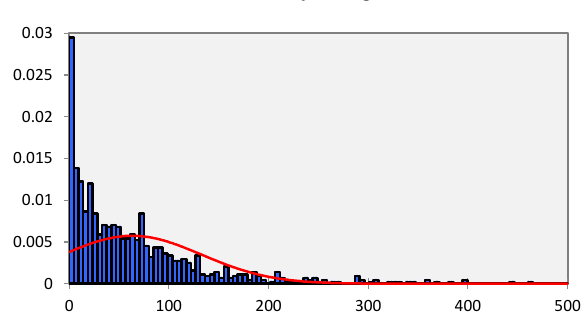
Figure 6. Sample histogram of point cloud density for a wall